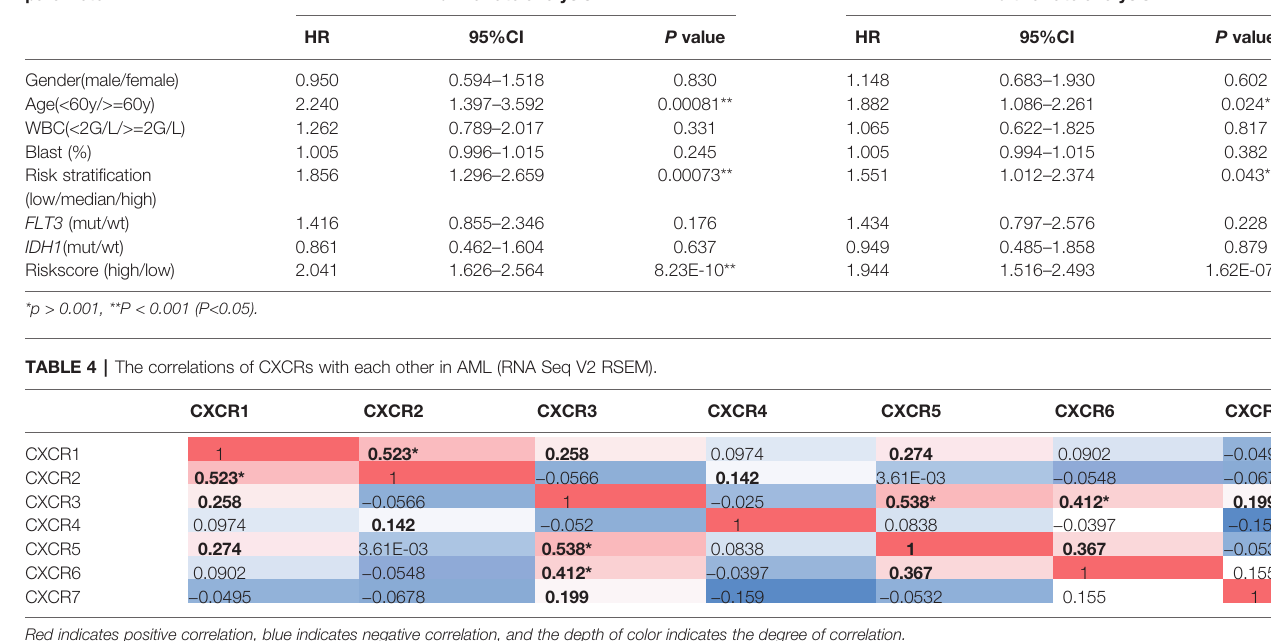
Red indicates positive correlation, blue indicates negative correlation, and the depth of color indicates the degree of